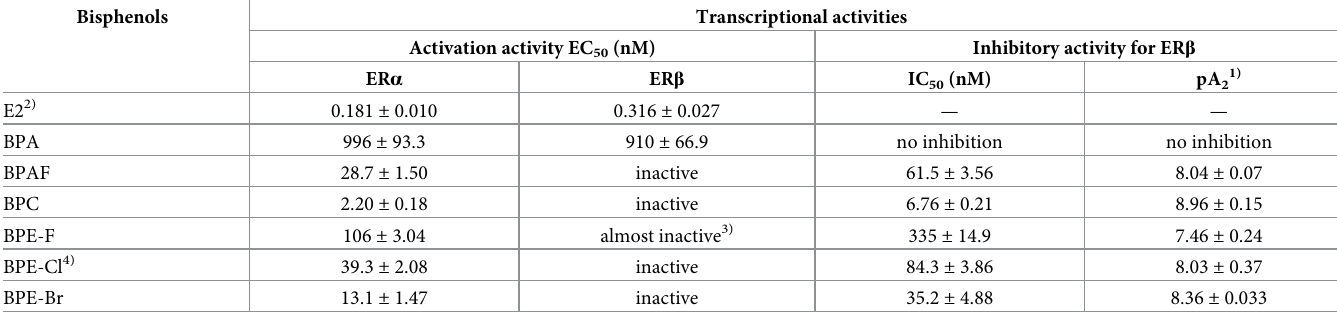
Table 2. Transcriptional activity of bisphenols for estrogen receptors ER α and ER β